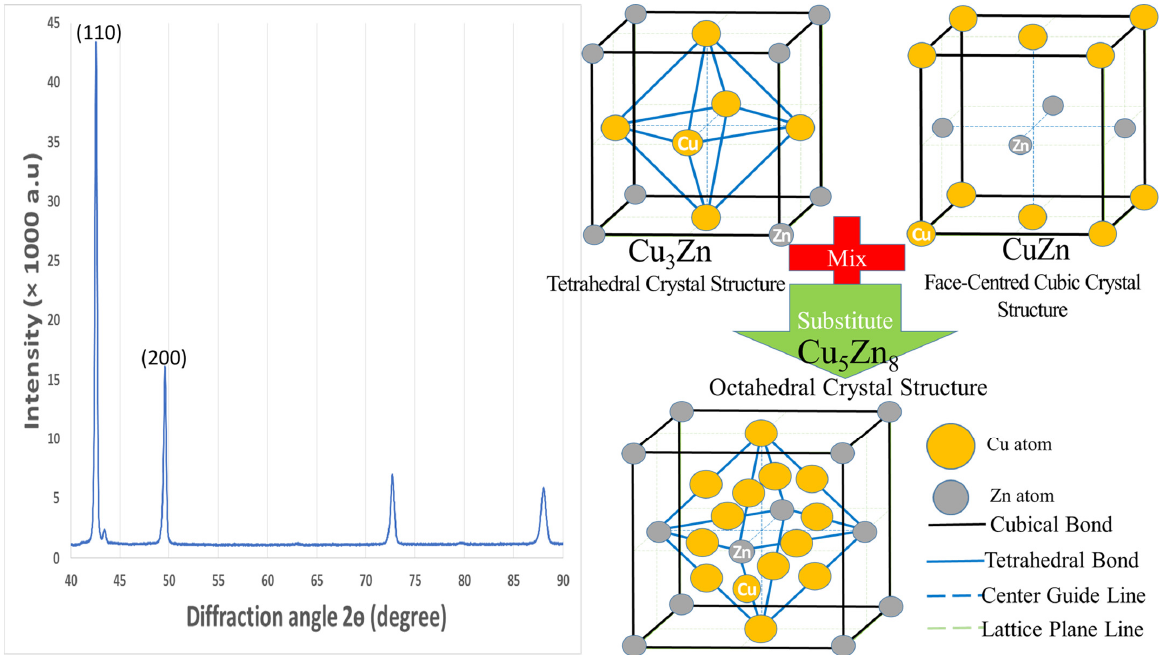
Figure 6. The X-ray diffraction pattern and the superlattice structure illustration for low brass